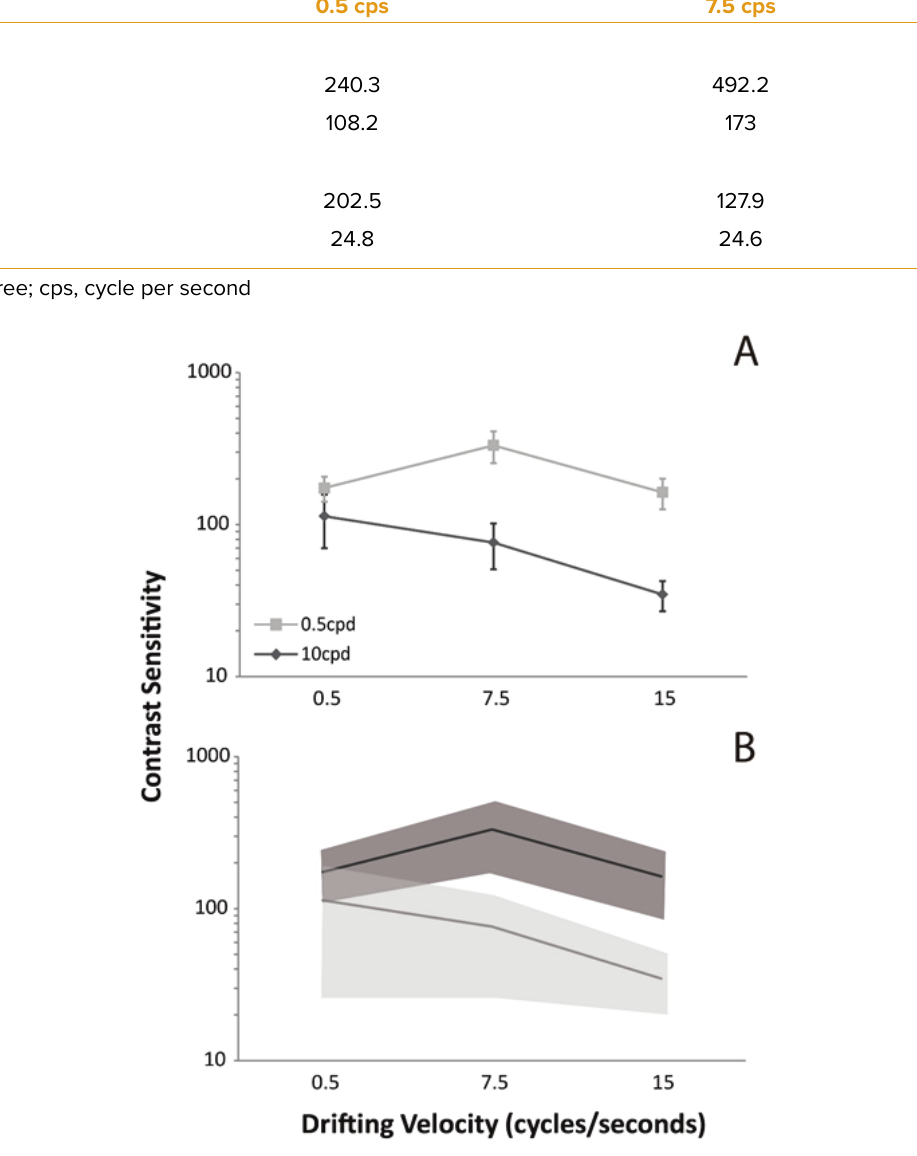
Figure 2. The psychophysical CS signature for the low (0.5 cpd) and high (10 cpd) spatial frequency. (A) The mean and standard deviation of the spatiotemporal interaction. (B) The normality range to be used for clinical purposes. In both panels, it is evident that the middle and high temporal frequencies are more discriminable areas to isolate the MC and PC contribution in the CS.